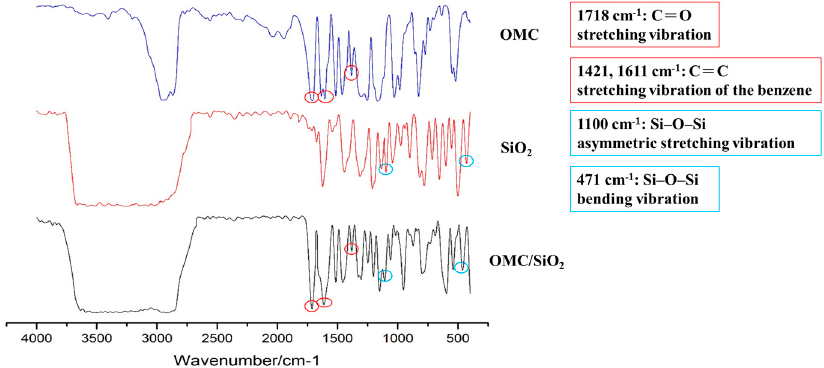
Figure 3. Fourier transform infrared (FTIR) spectroscopy of OMC/SiO 2 nanoparticles.